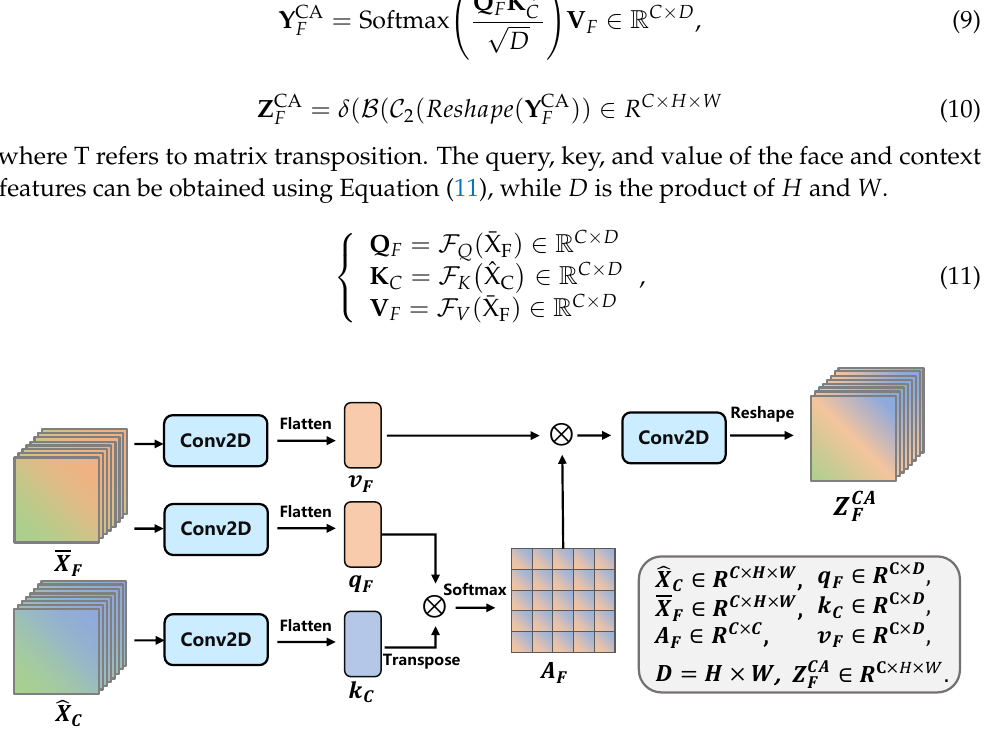
Figure 6. Architecture of cross-attention in the fist I-R pair. The complementary information is extracted via a cross-channel interaction using the CA operation. Z CA corresponding output. The detailed shape of each tensor is presented in this